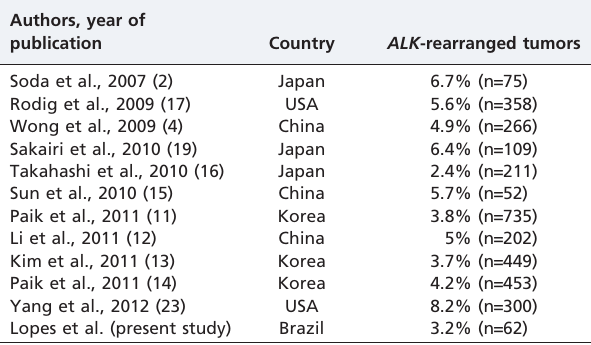
Table 1 - Prevalence of ALK -rearranged NSCLC in different